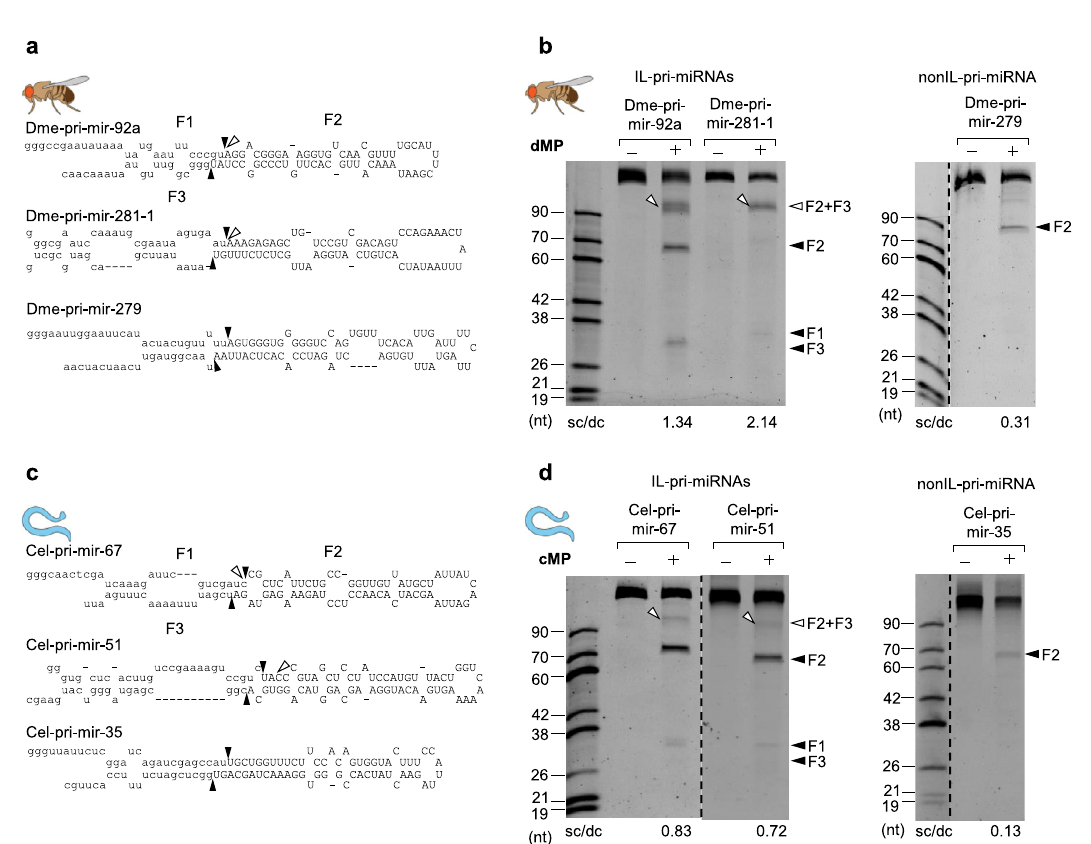
Fig. 2 The single cleavage of the DROSHAs in animals. a , c Diagrams and sequences of pri-miRNAs from D. melanogaster and C. elegans . b , d Pri-miRNA cleavage assays. Three pmol of each pri-miRNA were incubated with 3 μ L of fl y or worm Microprocessor-bound IgG beads (50% slurry) for 2 h at 37 °C. dMP, D. melanogaster Microprocessor; cMP, C. elegans